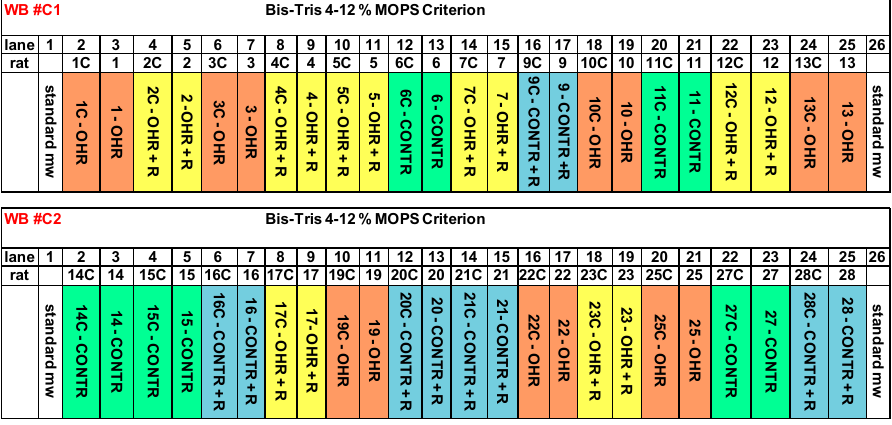
Figure 4. Representative images of the Western blots for nephrin, α 1 Na-K ATPase, PKG1 and Bcl2 of the chronic experiment. GAPDH was used as loading control. Standards of molecular weight are shown on the left and right in red (MW: nephrin 185 kDa; Na-K ATPase 95 kDa; PKG1 75 kDa; Bcl2 26 kDa). Two gels are shown: WB #C1 and WB #C2 (26 wells). Lane legends are indicated in the lower panel, each lane representing one rat of the four groups: control, control + rostafuroxin (R), OHR, OHR + rostafuroxin (R).